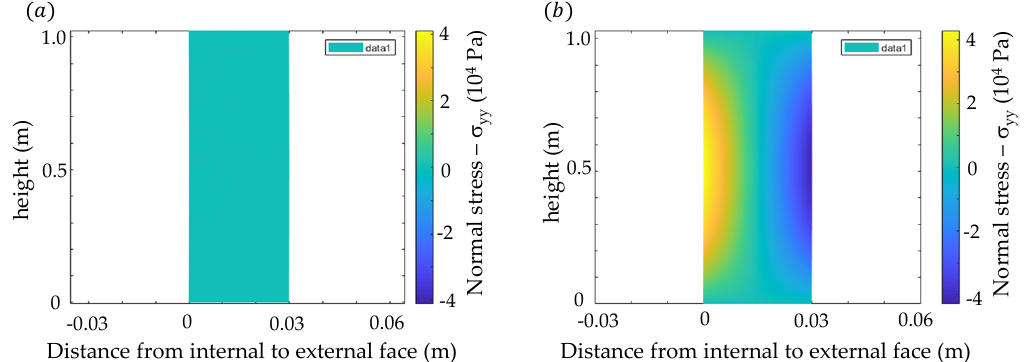
Figure 8. Evaluation of normal stress distribution ( σ yy ) in steady heat flux (t → ∞ ): ( a ) linear ( b ) nonlinear.